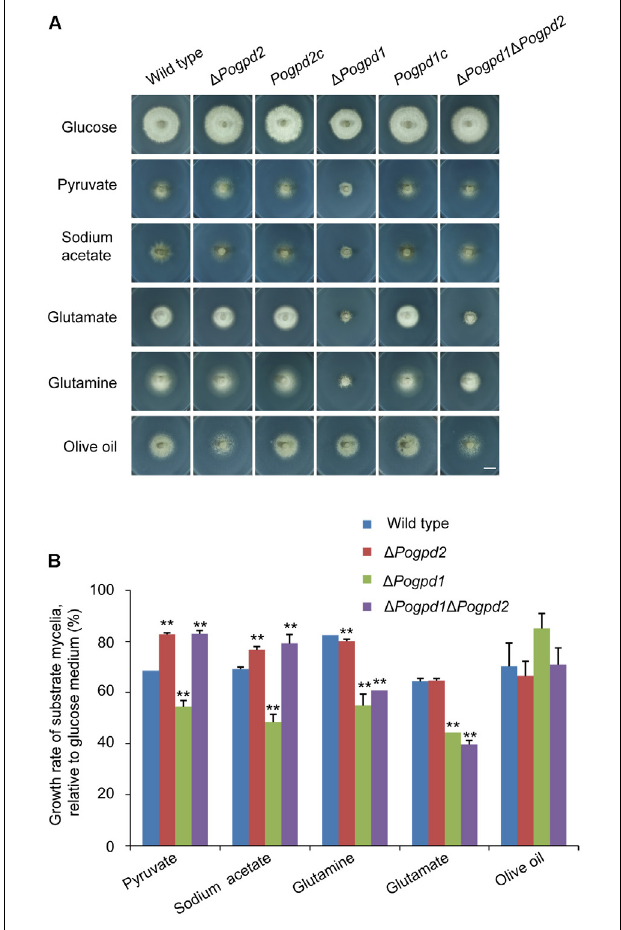
FIGURE 4 | Roles of glycerol-3-phosphate dehydrogenases in utilization of carbon sources. (A) Mycelial colonies of the wild type, (cid:49) Pogpd1 , (cid:49) Pogpd2 , and (cid:49) Pogpd1 (cid:49) Pogpd2 , and the complementation strains Pogpd2c and Pogpd12c , grown at 25 ◦ C for 8 days on MM medium (glucose), or MM in which 1% glucose was replaced by 50 mM sodium acetate, 5 mM sodium pyruvate, 1.15% sodium glutamate, 1% glutamine, or 1% olive oil as the sole carbon source. Bar, 10 mm. (B) Growth rate of the wild type, (cid:49) Pogpd1 , (cid:49) Pogpd2 , and (cid:49) Pogpd1 (cid:49) Pogpd2 , cultured in MM-C medium containing 50 mM sodium acetate, 5 mM sodium pyruvate, 1.15% sodium glutamate, 1% glutamine, or 1% olive oil relative to that in MM medium (1%